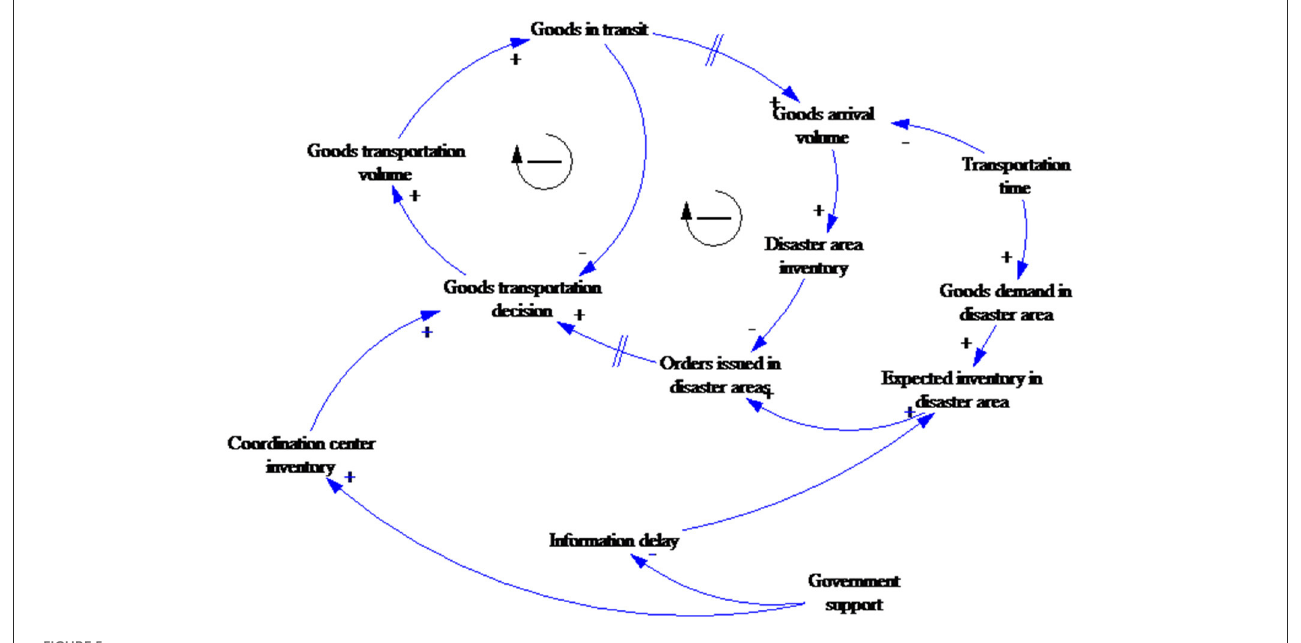
FIGURE5 Relief goods supply system casual loop diagram (including government support).